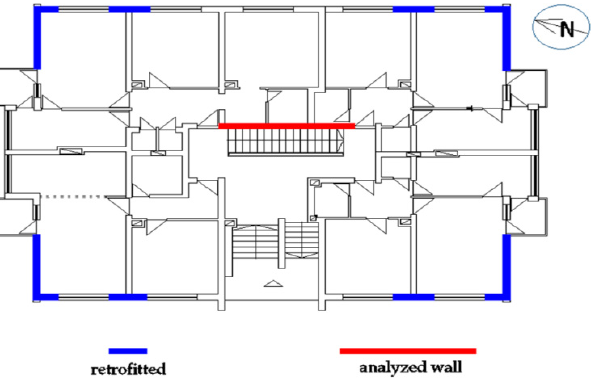
Figure 28. The floor plan showing retrofitted exterior walls (blue color) and the analyzed wall Figure 28. The fl oor plan showing retro fi tt ed exterior walls (blue color) and the analyzed wall (red (red color). color).